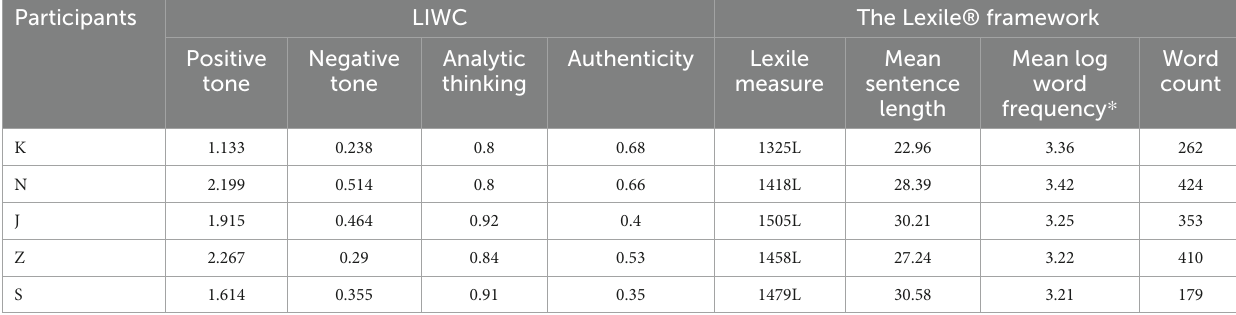
TABLE 3 LIWC and Lexile mean scores for all five participants. Participants